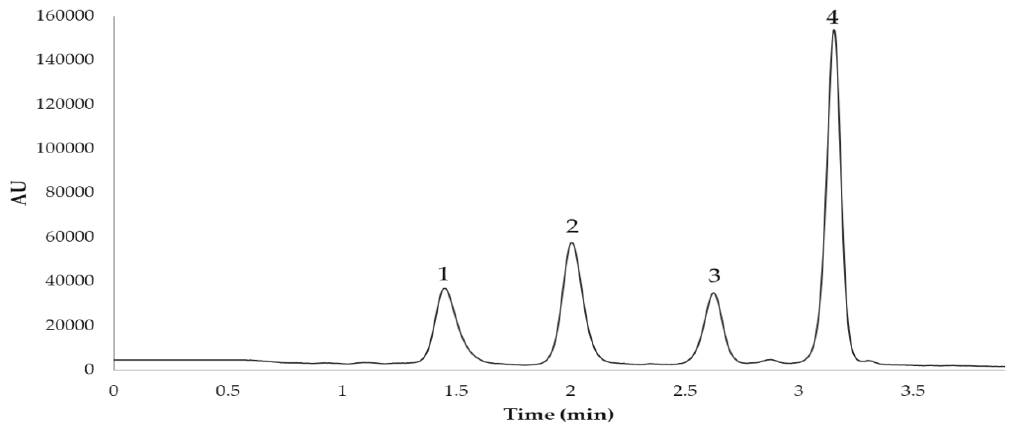
Figure 2. Chromatogram of the anthocyanins identified in the sloe samples. Peak correspondence: 1) cyanidin 3- O -glucoside; 2) cyanidin 3- O -rutinoside; 3) peonidin 3- O -glucoside; 4) peonidin 3- O - rutinoside.